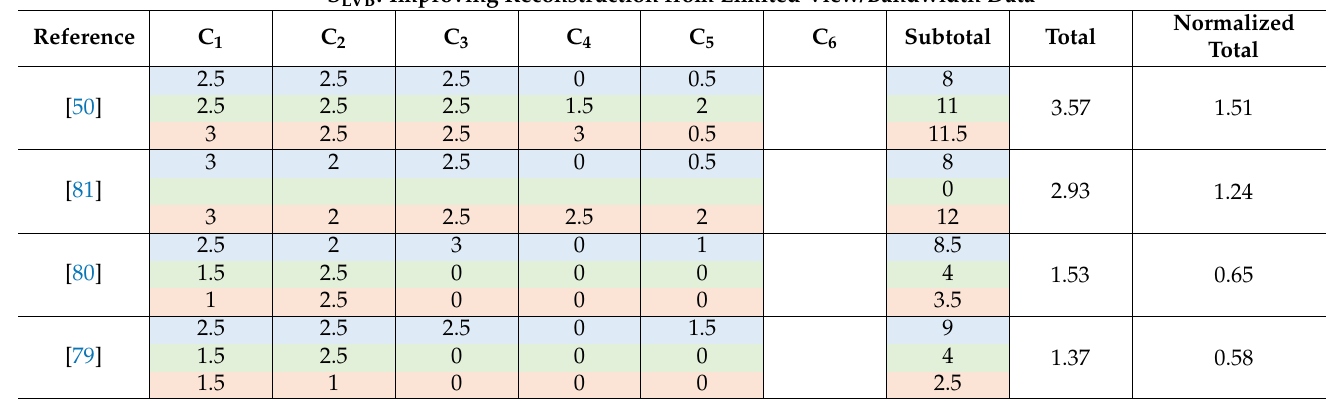
Table A6. Analytical ratings for all studies included in S LVB . The color in the table rows indicates the category of experiments as follows: numerical experiments , experiments with phantoms , and experiments with humans in vivo . The evaluation criterion C 6 was not applicable to this subgroup, thus the corresponding column was left